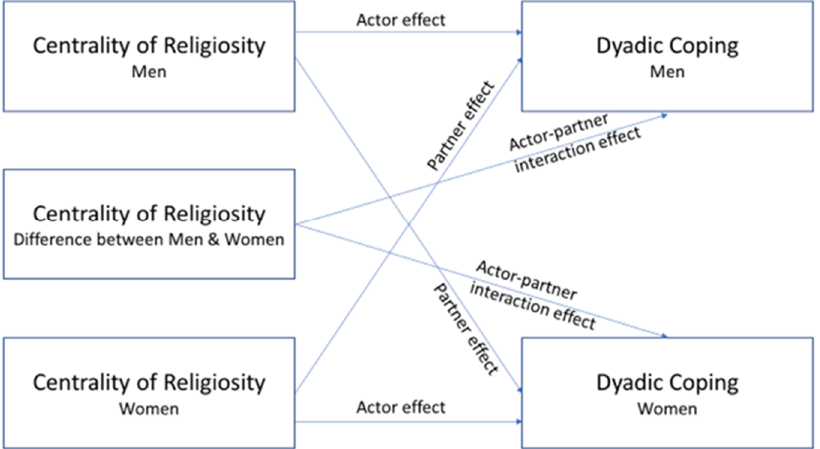
Figure 1. Centrality of religiosity effects on dyadic coping. Base model. Note. The model also includes type of relationship as a covariant affecting all variables (not depicted for clarity of presentation).